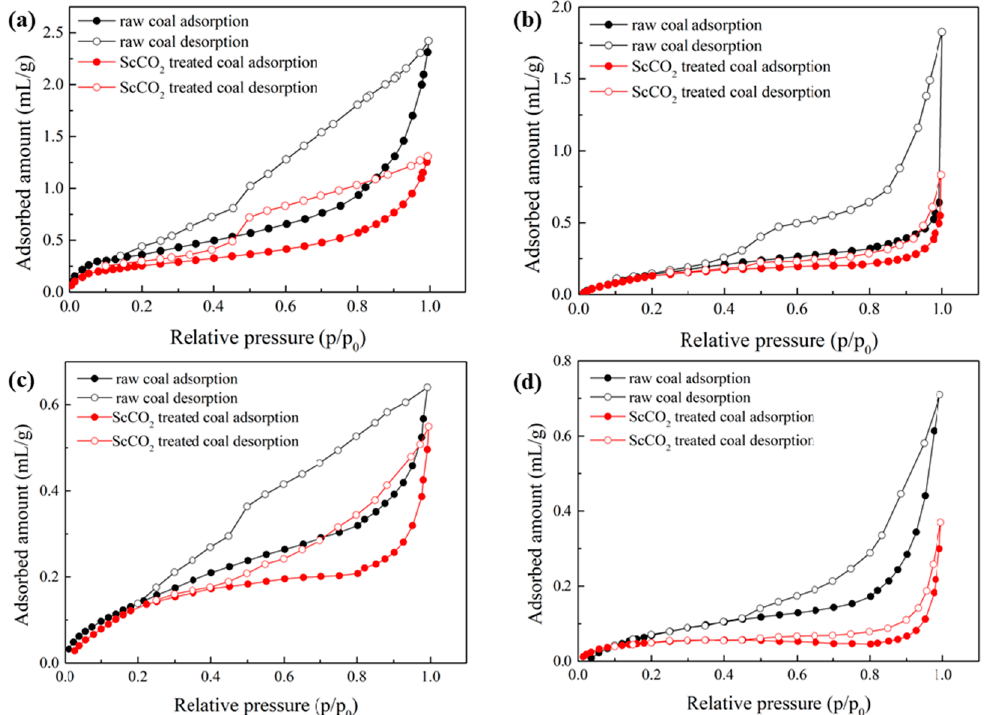
Figure 4. N 2 adsorption-desorption isotherms on the raw and ScCO 2 -treated coal samples at − 196 °C: ( a ) DL coal; ( b ) ZL coal; ( c ) GY coal; ( d ) DT coal.